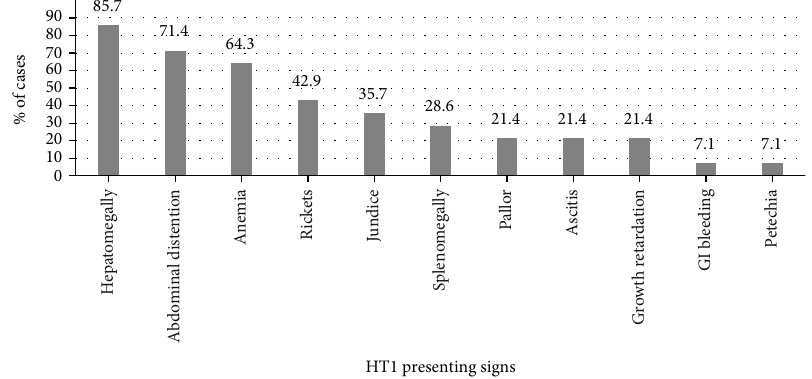
Figure 2: Presenting signs of HT1.